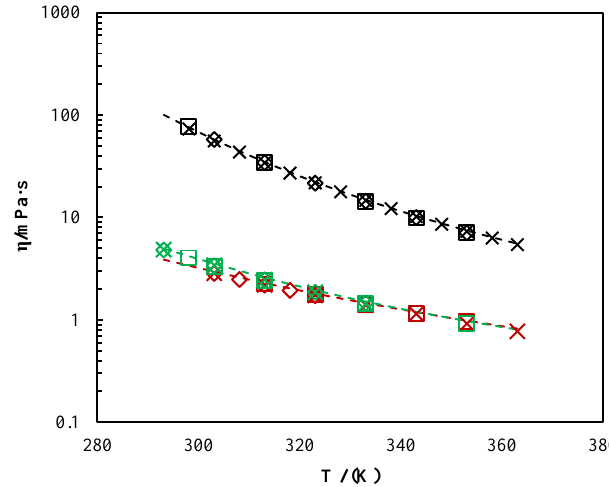
Figure 2. Viscosity of MDEA: “– – –“—this work; “ ◻ ”—Teng et al. [43]; “ ◇ ”—Li and Lie [24]; “x”—